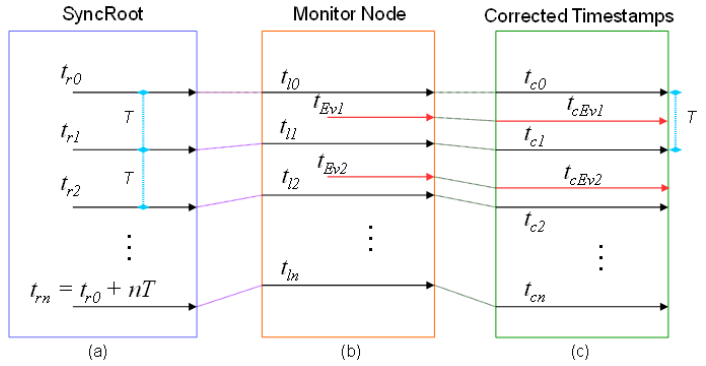
Figure 6. Schematic of global trace synchronization method. ( a ) The SyncRoot generates the sync points periodically; ( b ) The Monitor Node registers events and synchronization points; ( c ) The timestamps are corrected.